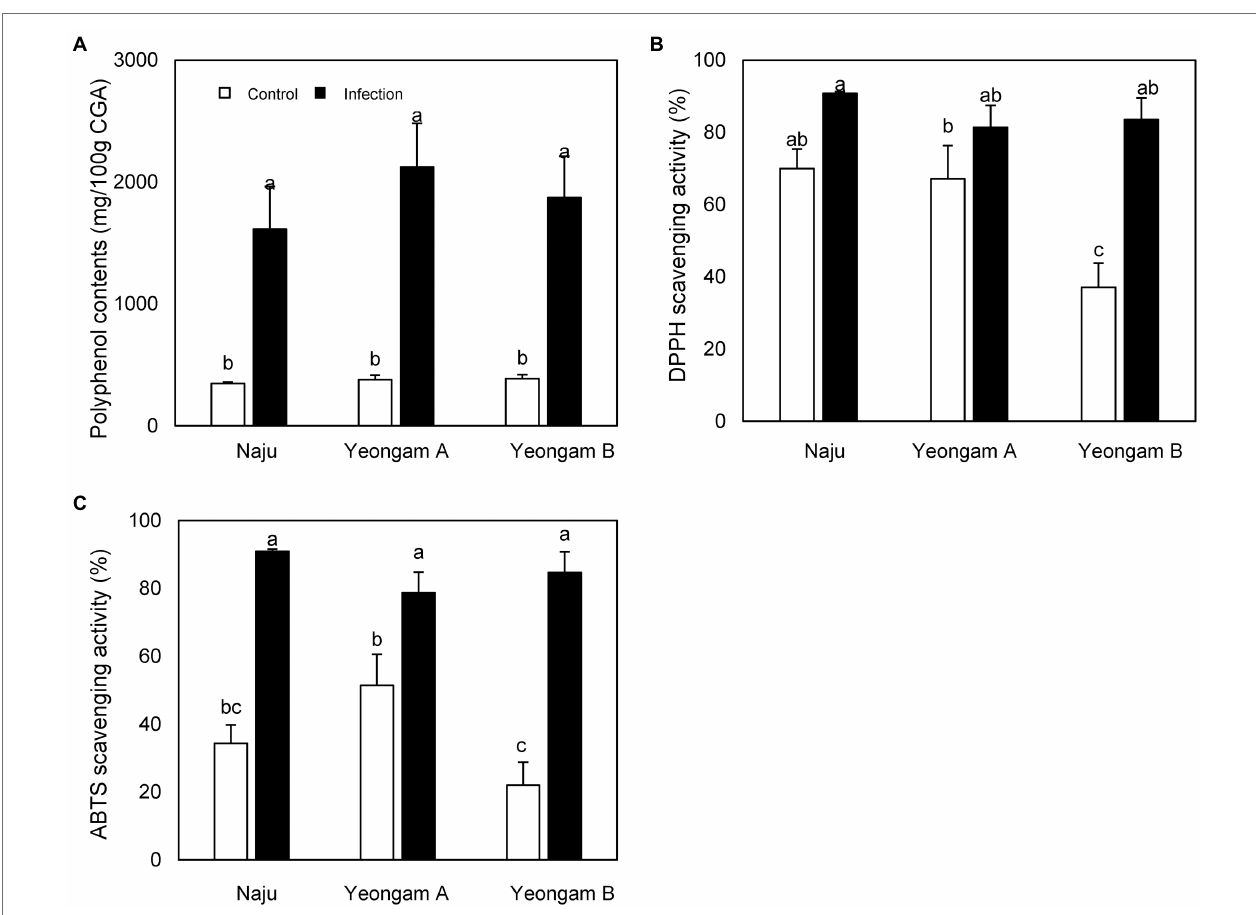
FIGURE 7 | Antioxidant activity of sweetpotatoes infected with root rot in the three fields—Naju, Yeongam A, and Yeongam B. (A) Total polyphenol contents. (B) DPPH scavenging activity (%). (C) ABTS scavenging activity (%). Data are expressed as mean ± S.D. ( n ≥ 4). Each value of different letters (a–c) above bars is significantly different by Duncan’s multiple range test at p <